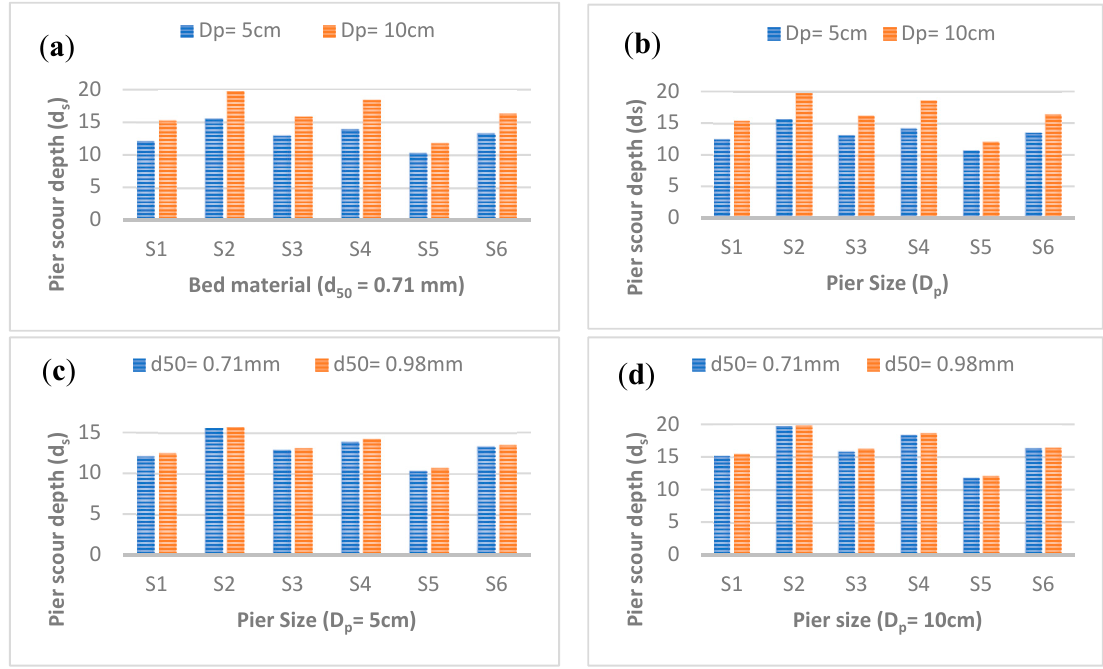
Figure5. Comparisonofscourdepthfordi ff erentpiershapeswithdi ff erentpiersizes: ( a ) d 50 = 0.71 mm, Figure 5. Comparison of scour depth for different pier shapes with different pier sizes: ( a ) d 50 = ( b ) d 50 = 0.98 mm; with di ff erent bed materials: ( c ) D p = 5 cm, ( d ) D p = 10 0.71 mm, ( b ) d 50 = 0.98 mm; with different bed materials: ( c ) D p = 5 cm, ( d ) D p = 10 cm.